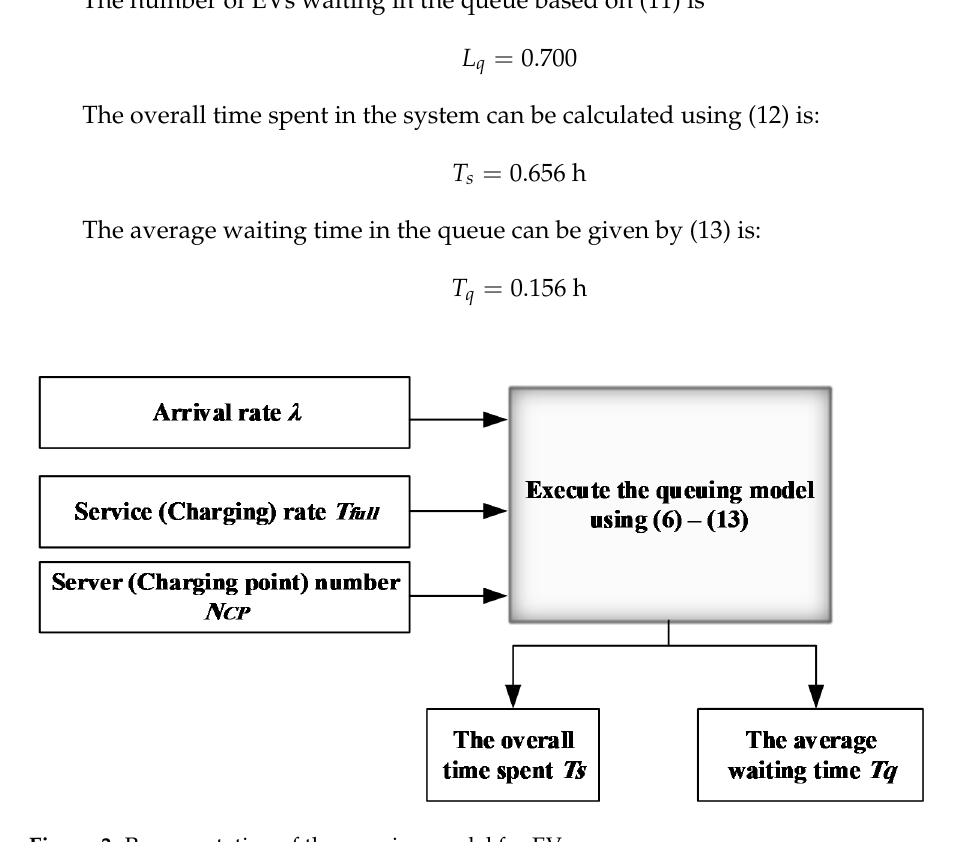
Figure 3. Representation of the queuing model for EV.